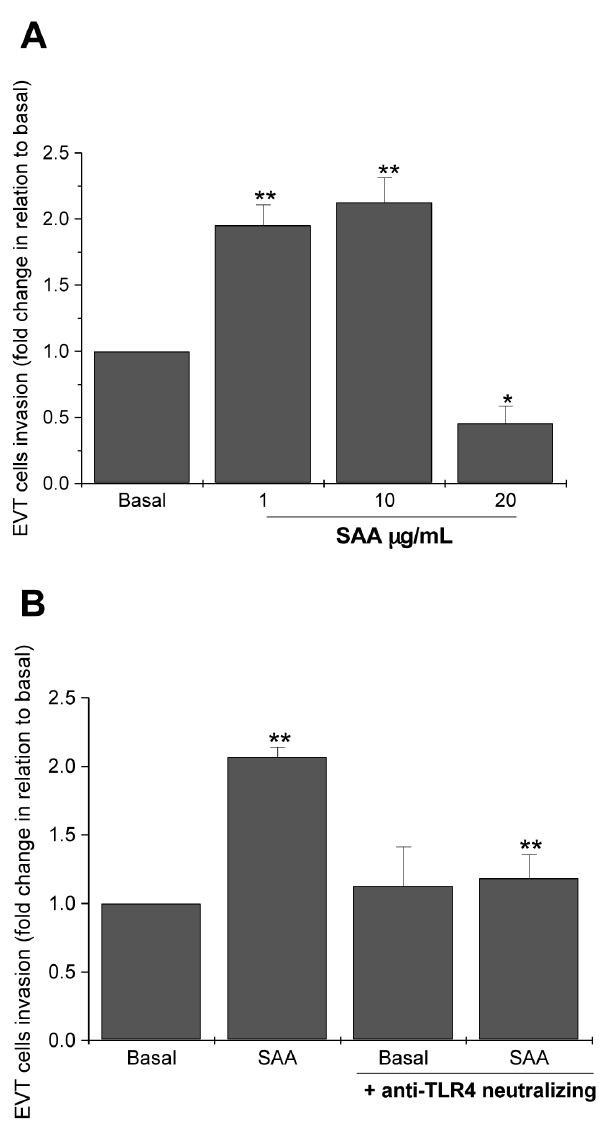
Figure 3. Effects of SAA on EVT cells. (A) SAA dependent on concentration affected the invasiveness of EVT cells in a Matrigel-coated transwell assay cultured for 48 h. (B) Inhibitory effect of a TLR4- neutralizing antibody on SAA-induced invasion of EVT cells. The data represent the median 6 SE of four independent experiments performed in duplicate. * p , 0.05 vs . basal; ** p , 0.01 vs . basal and treatment with the TLR4-neutralizing antibody.